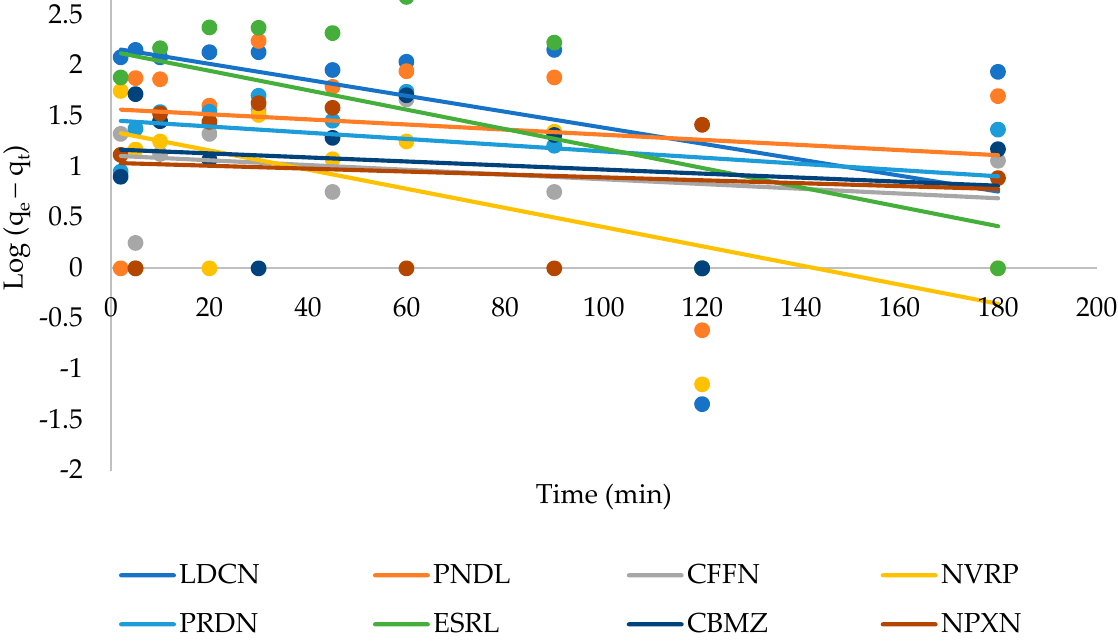
Figure 5. Pseudo ‐ first ‐ order plot for the adsorption of pharmaceutical drugs.